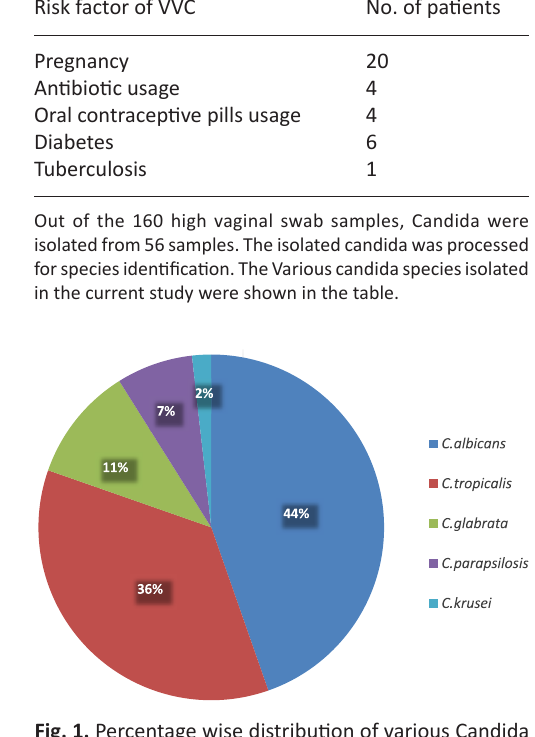
Table 2. Risk factors associated with the study subjects : Risk factor of VVC